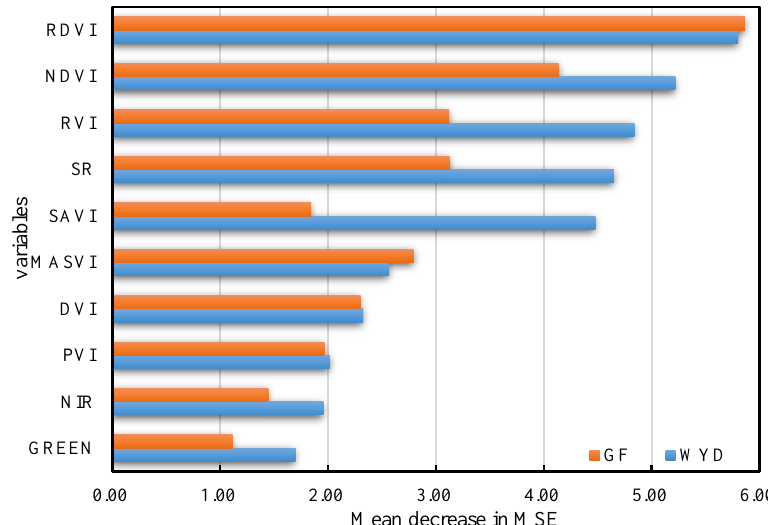
Figure 3. Variable importance for the random forest (RF) models of the two pilot regions. RDVI—Return To Vegetation Index, NDVI— Normalized Di ff erence Vegetation Index, RVI—Perpendicular Vegetation